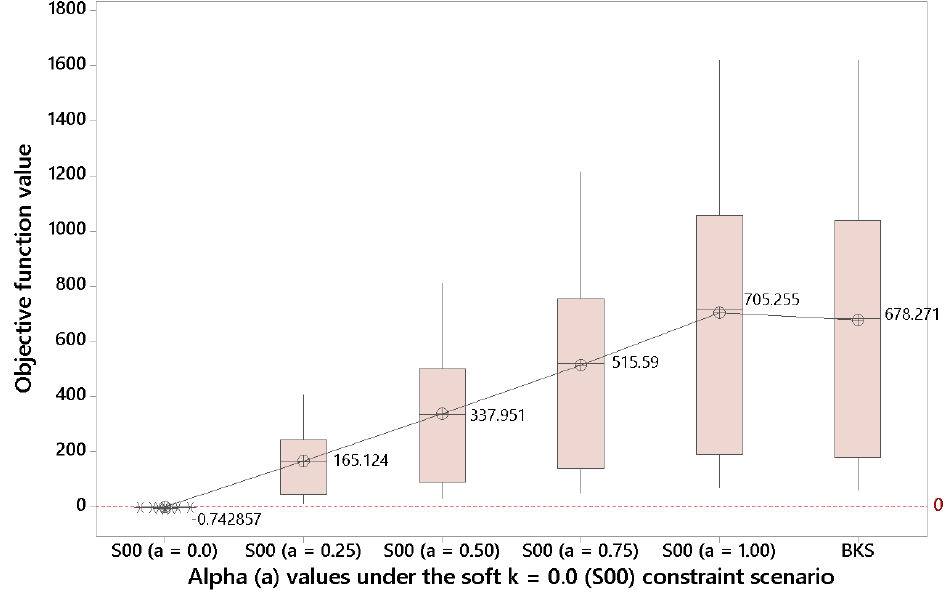
Figure 5. Results for different alpha values under the soft constraint scenario with k = 0.0 (source: own